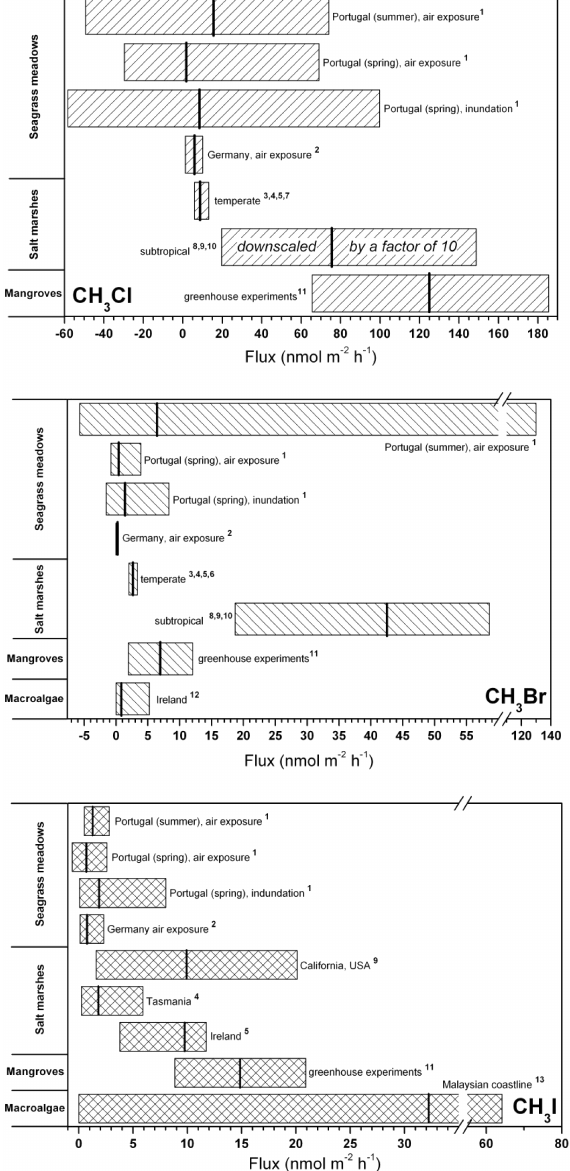
Figure 3. Compilation of mean emissions (bold black vertical lines) and ranges from different sources in coastal environments for CH 3 Cl (upper panel), CH 3 Br (middle panel) and CH 3 I (lower panel). Note the different scales. Published data adopted from: 1 this study; 2 Weinberg et al. (2013); 3 Blei et al. (2010); 4 Cox et al. (2004); 5 Dimmer et al. (2001); 6 Drewer et al. (2006); 7 Valtanen et al. (2009); 8 Rhew and Mazéas (2010); 9 Manley et al., (2006); 10 Rhew et al. (2000); 11 Manley et al. (2007); 12 Carpenter et al. (2000); 13 Leedham et al. (2013). Note that the data of CH 3 Cl from subtropical salt marshes are downscaled by a factor of 10 for visualisation reasons. Where multiple references were used, the individual study means were averaged and presented along with the resulting ranges. Thus, ranges of halocarbon fluxes in each single study are not covered. Studies reporting a strong species dependency in magnitude of fluxes were averaged over all species groups for simplicity. Macroalgae emissions given in g fresh weight per hour were converted by using the species’ fresh weights and spatial coverage in the coastal belt in Mace Head, Ireland for CH 3 Br (Carpenter et al., 2000) and the Malaysian coastline for CH 3 I (Leedham et al., 2013),